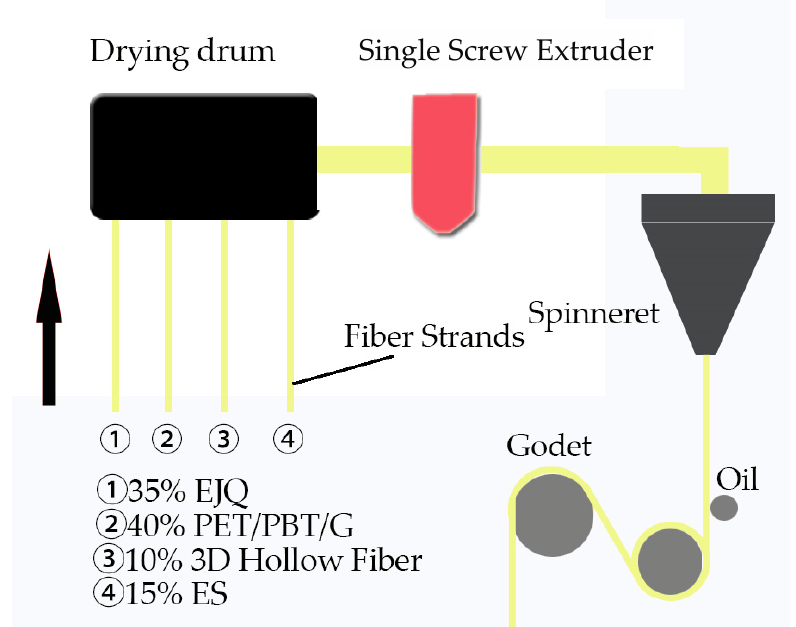
Figure 1. A schematic diagram of PLON fiber production. PLON mattresses with different densities and structures were selected for the mattress hardness classification test and mattress delamination hardness test as the research objects, which were provided by Jinquan New Materials Co., Ltd. (Suzhou, China). Coir mattresses, spring mattresses and FPF were used as the comparative samples provided by Jinquan New Materials Co., Ltd. (Suzhou, China). Two levels of PLON density were selected: 30 kg/m 3 (hereinafter referred to as P30) and 40 kg/m 3 (hereinafter referred to as P40). One level of FPF density was selected: 30 kg/m 3 (hereinafter referred to as F30). The sizes of the PLON block and FPF block were 380 × 380 × 20 mm, the PLON mattress and coir mattress were 380 × 380 × 95 mm and the spring mattress was 380 × 380 × 215 mm. The repetition amount of each sample was three pieces. All samples were tested in an environment with a temperature of 23 ± 2 ◦ C and a humidity of 45–55%. Table 1 gives the mattress structure configuration of different mattress groups. Nonwoven fabric made of PET fiber and PP fiber is commonly applied on mattresses to separate spring and filling materials. Figure 2 is the scanning electron microscope (SEM) figure of the PLON blocks. The PLON fibers inside the PLON cushion are arranged in a disorderly manner. The fiber network structure is fluffy with a large void structure. There are not many bonding points. After pressing, some fibers will break. ES fiber is made by two components with skin-core structure. The melting point of the skin fiber is low, and it can be melted at a lower temperature to play a bonding role. EJQ fiber can provide elasticity for composite fibers and play a bonding role